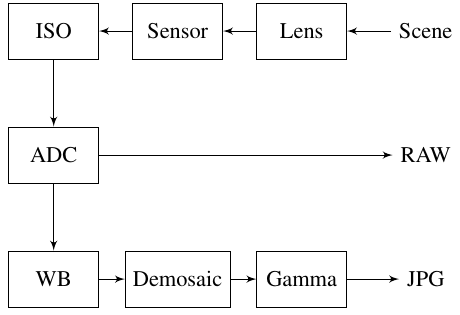
Figure 3. typical processing steps in the image